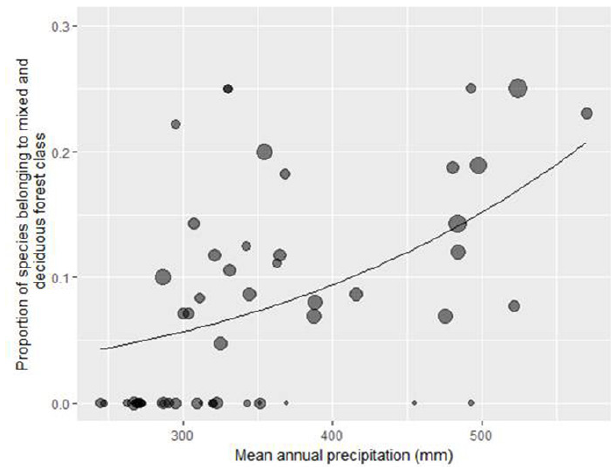
Fig 2 . Relationship between proportion of species on the mixed and deciduous forest class and mean annual precipitation. Solid line, logistic regression model expectation. Dots, empirical data grouped on 10×10 km UTM squares. Size of dots is proportional to the total number of ant species recorded on the square. Two squares with one and two species, respectively, are not represented on the figure as they are out of range (proportion of mixed and deciduous forest class 0.5 and 1). Intercept: -4.4427 ± 0.5479, z= -8.108, P=<0.001; Precipitation: 0.0054 ± 0.0013, z= 4.271, P=<0.001.